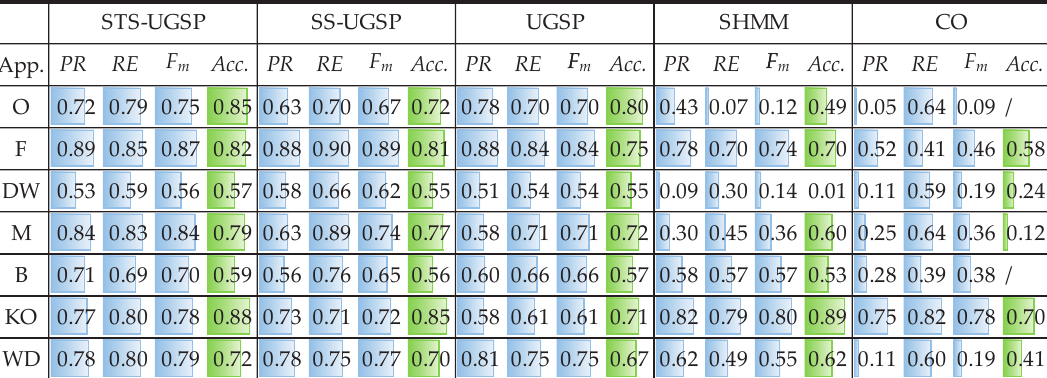
Figure 10. NILM Performance comparison on REDD House 1.